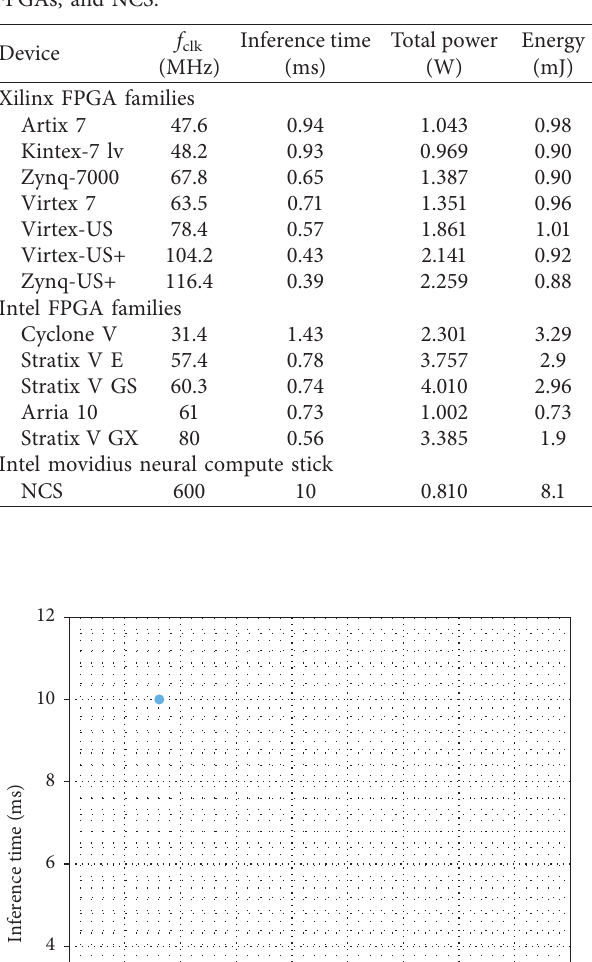
Table 10: Performance comparison between Xilinx FPGAs, Intel FPGAs, and NCS.